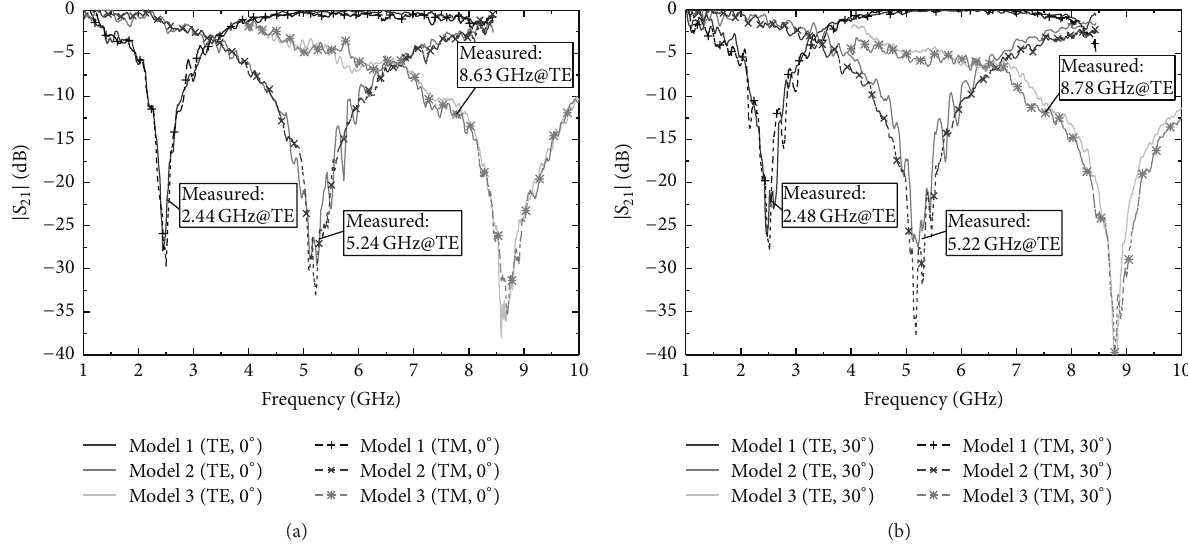
Figure 6: Measured transmission characteristics of the proposed FSSs: (a) normal incidence, 0 ∘ ; (b) 30 ∘ angle of incidence.